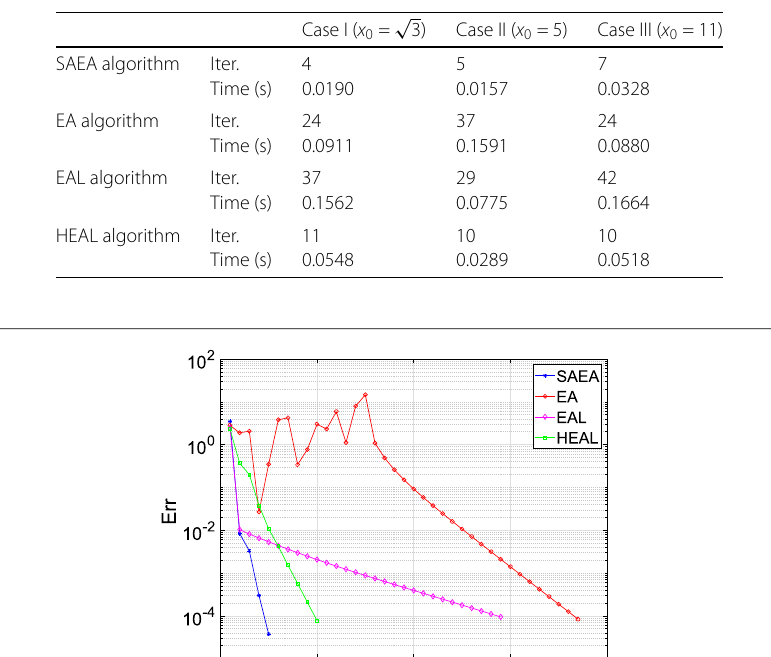
Figure 1 Example 4.1, Case I